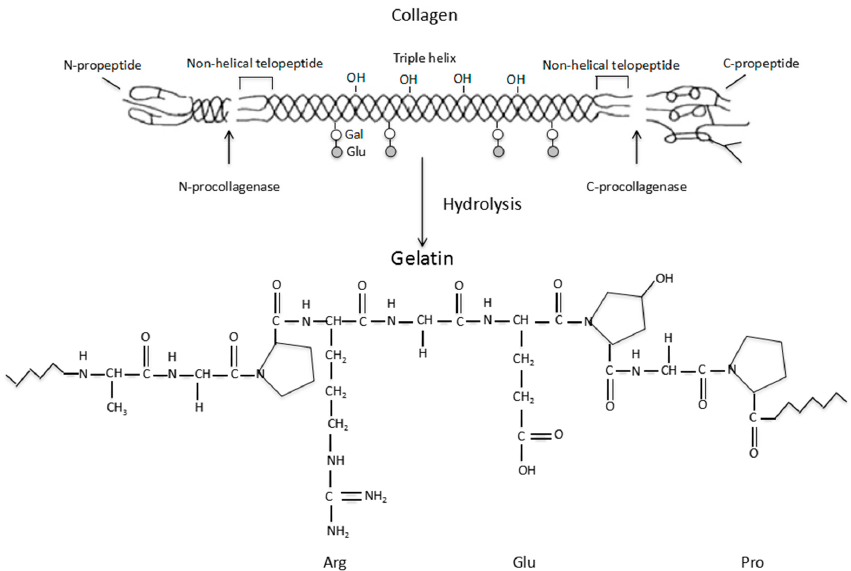
Figure 1. Schematic description of the collagen hydrolysis to gelatin.